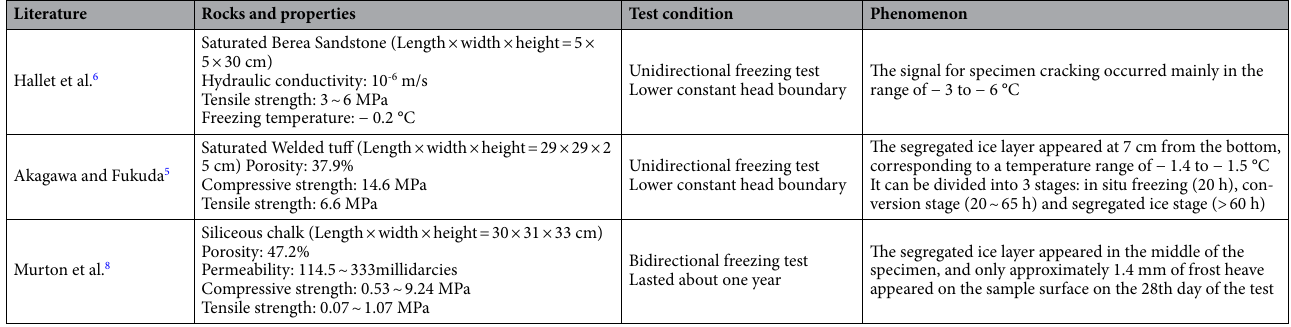
Table 1. Some typical ice segregation experiments and